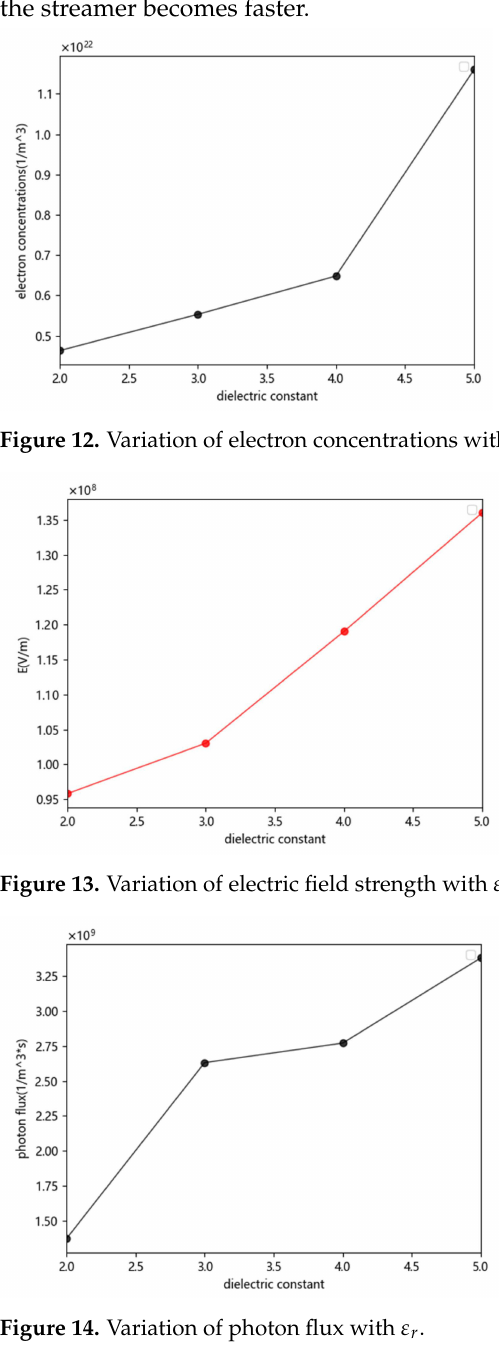
Figure 14. Variation of photon flux with ε r